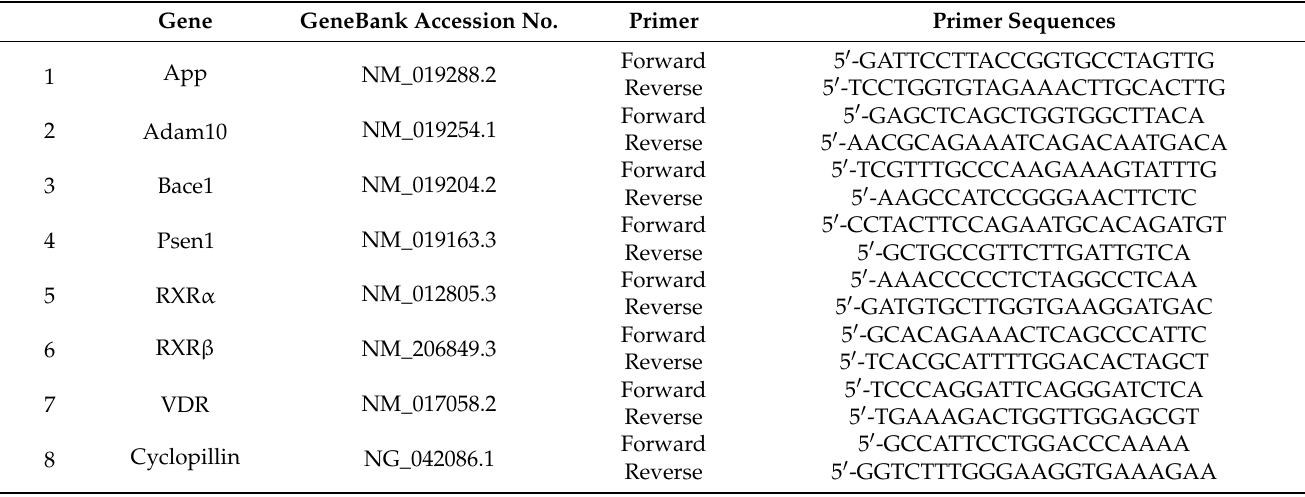
Table A1. qRT-PCR primer information used for detecting mRNA expression levels in this study (Figures 2b,c and 4a,d).